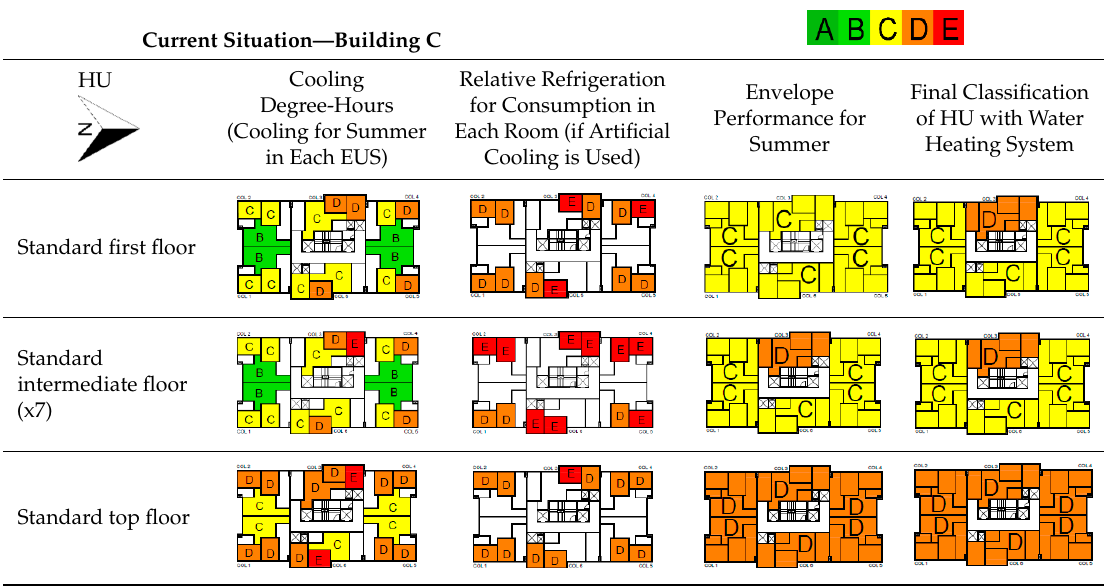
Table 7. Graphical representation of the standard floor of Representative Building C with the Table 8. Graphical representation of the standard floor of Representative Building D with the classification based on energy e ffi ciency evaluation. classification based on energy efficiency evaluation.